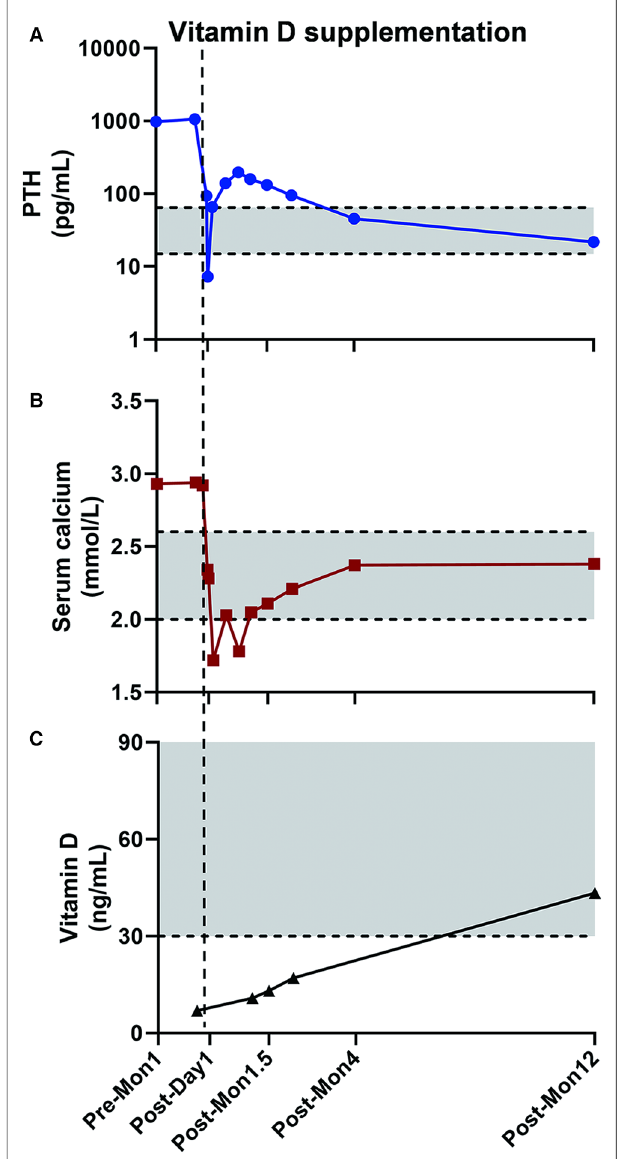
FIGURE 3 | The PTH, serum calcium, and Vitamin D level changed perioperatively. Grey area was the normal range PTH (15 – 65 pg/mL), serum calcium (2.00 – 2.60 mmol/L), and Vitamin D level ( ≥ 30 ng/mL) de fi ned at our center. The PTH level decreased immediately after the operation but